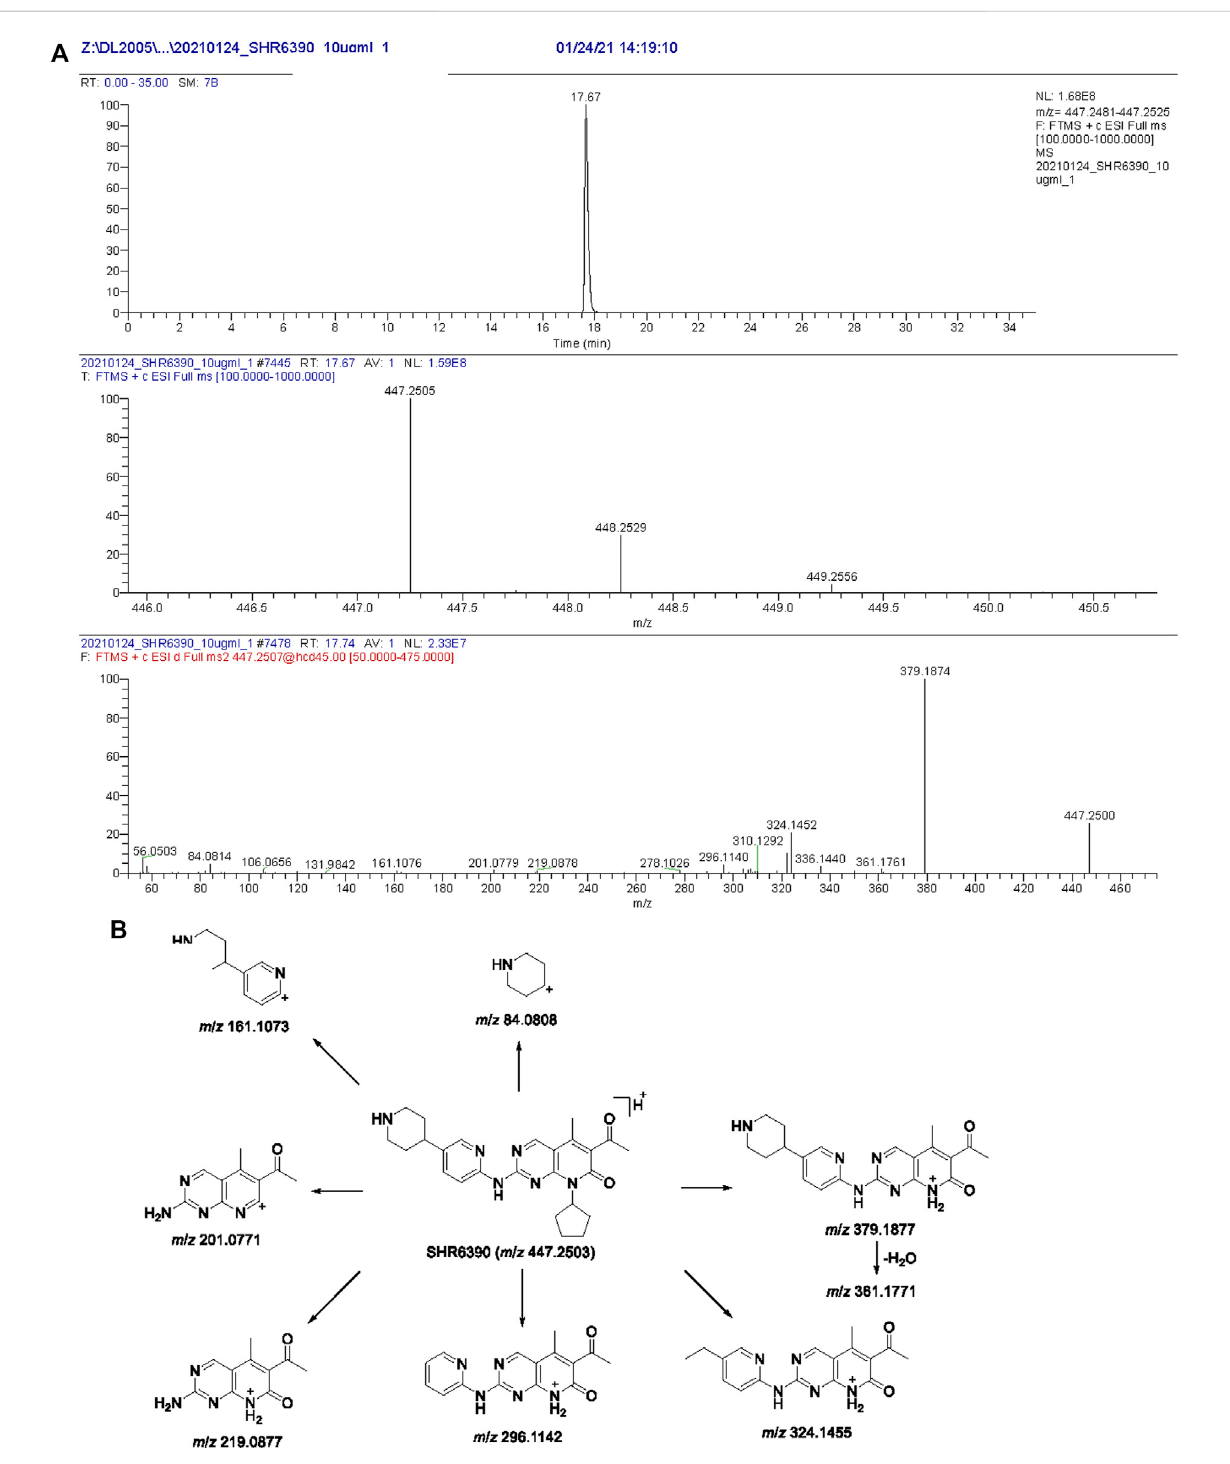
FIGURE 1 Extracted ion chromatograms, product ion spectra (A) and proposed fragmentation patterns of SHR6390 (B) .